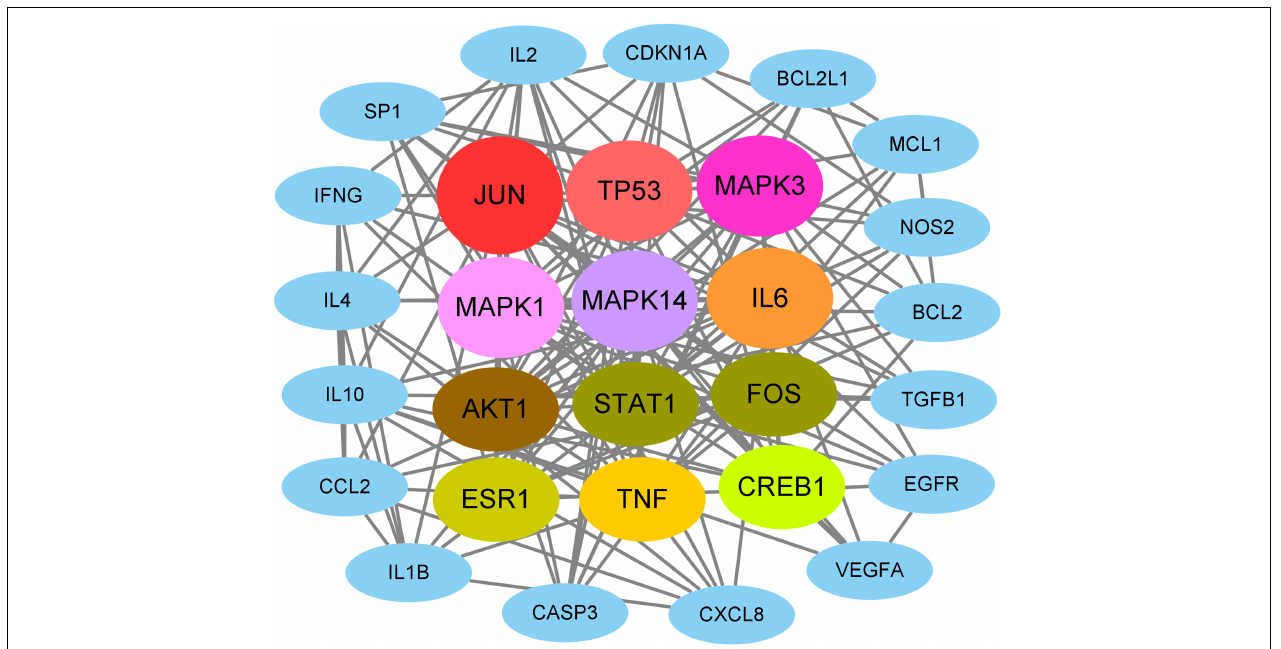
FIGURE 2 | Identification of all core targets involved in VA against As-linked